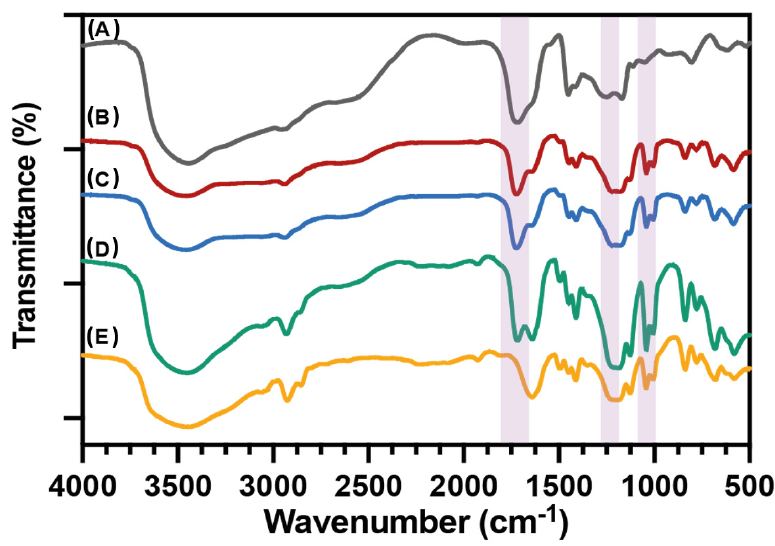
Figure 1. FTIR spectra of PAA and PSS homo- and P(AA- co -SS) copolymers. ( A ) PAA, ( B ) P(AA- co - SS) (70:30), ( C ) P(AA- co -SS) (50:50), ( D ) P(AA- co -SS) (30:70), ( E ) PSSNa. (70:30), ( C ) P(AA- co -SS) (50:50), ( D ) P(AA- co -SS) (30:70), ( E )